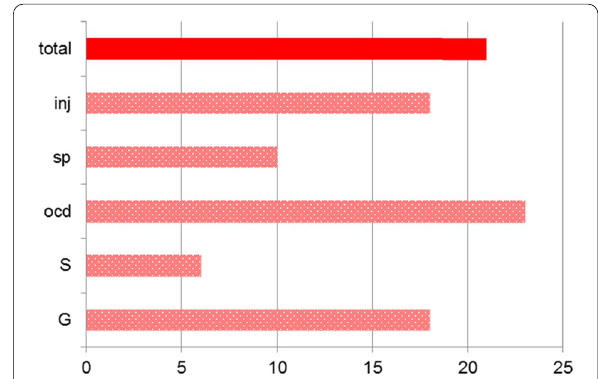
Fig. 1 Children with post-cochlear implants scores on Spence Preschool Anxiety Scale (total t -score and subscale scores)